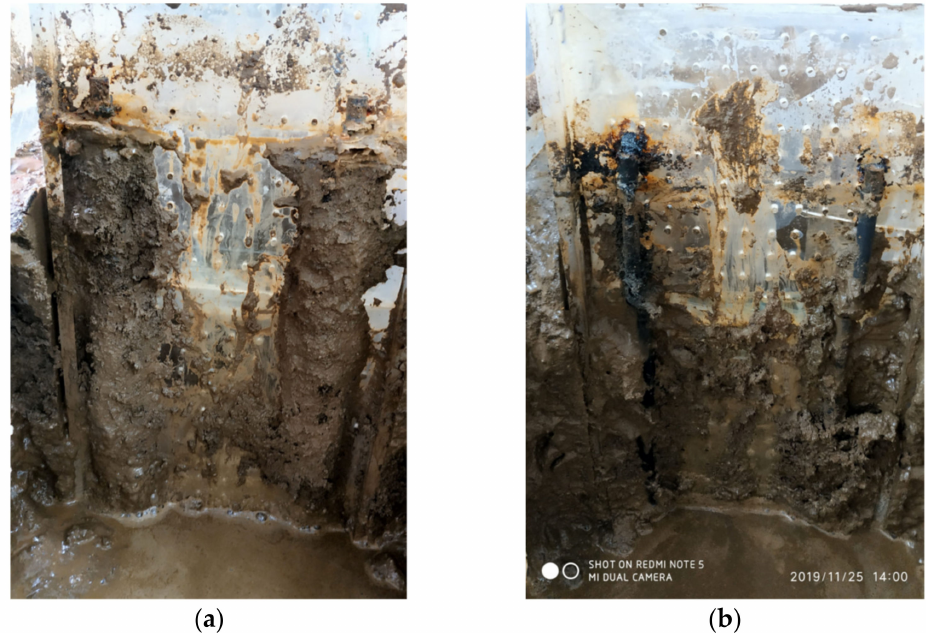
Figure 7. The precipitation of calcium carbonate (CaCO 3 ) at both ( a ) the anode and ( b ) the cathode for D60’s